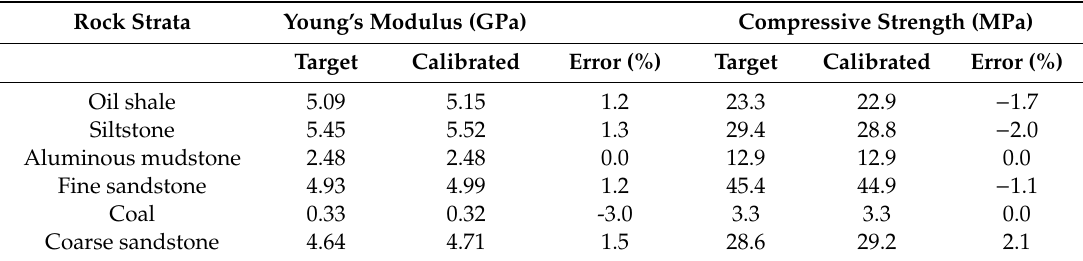
Table 3. Calibrated results of rock mass properties in the Trigon model.